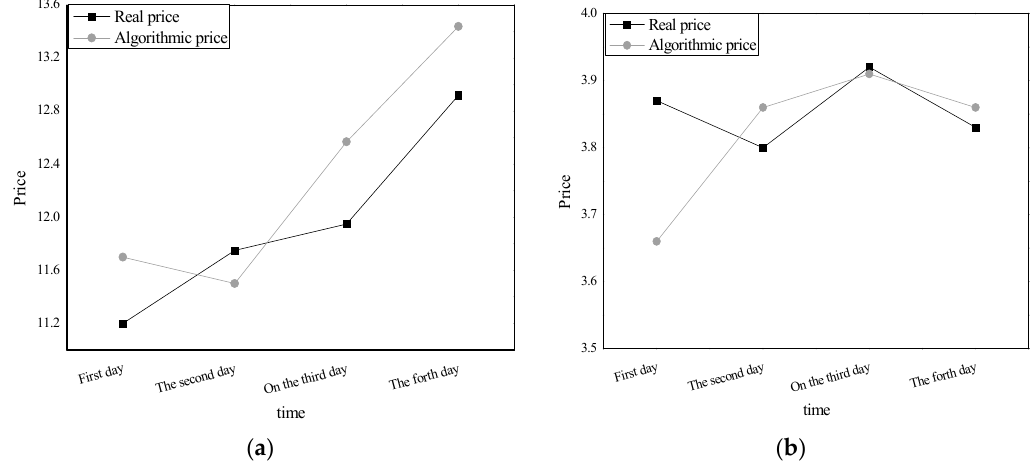
Figure 9. Analysis and research on ICO price trend of encrypted currency Yitaifang and Litecoin. ( a ) Etheric coin ( b ) Litecoin.